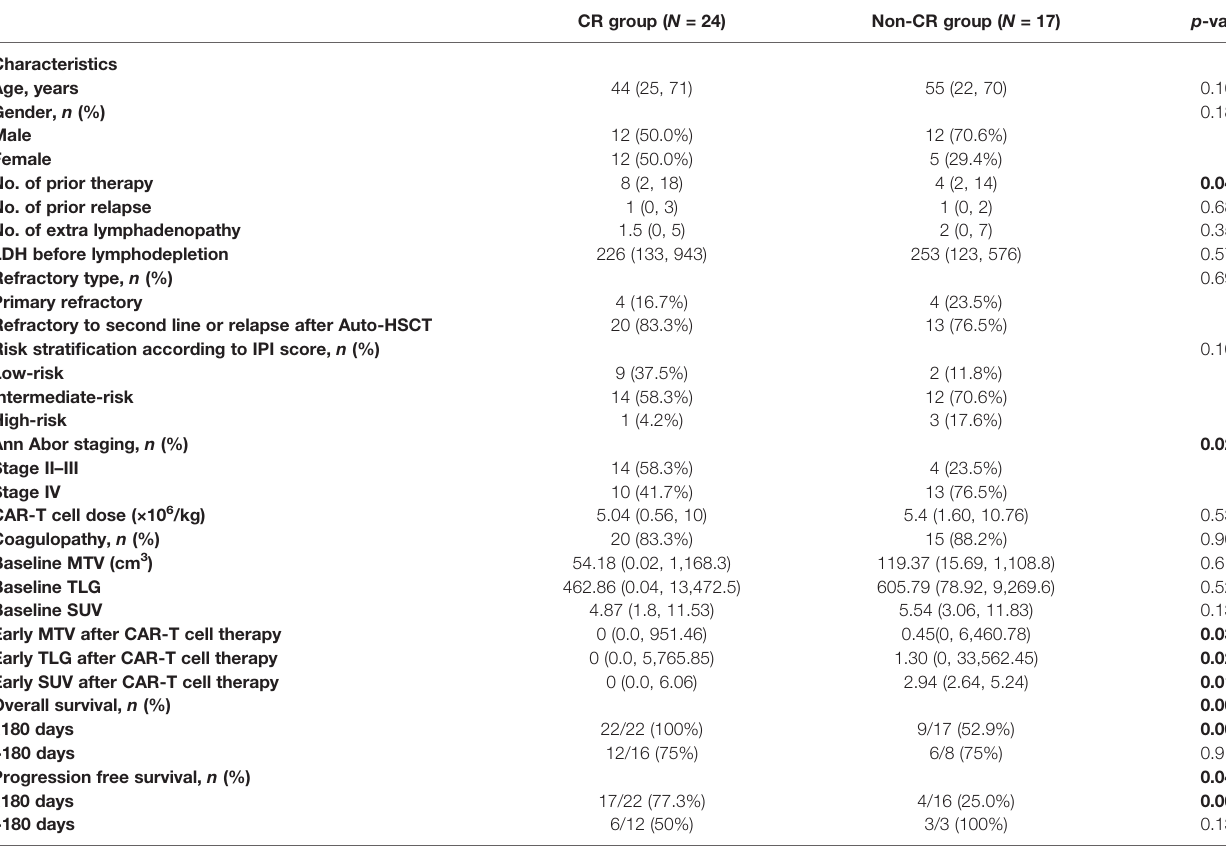
TABLE 1 | Patients ’